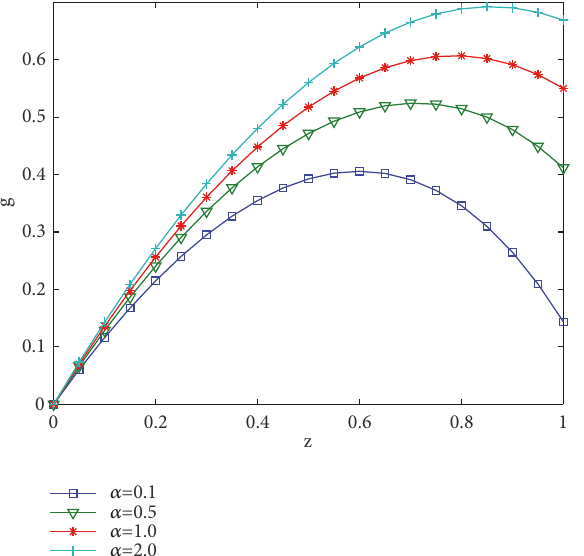
Figure 4: Flux distribution for 𝛼 = 1.0 , 𝑛 = 1.0 , ℎ(𝑧) = 1 − 𝑧 , 𝑘(𝑧) = 𝑧, 𝑧 2 , 𝑧 3 .